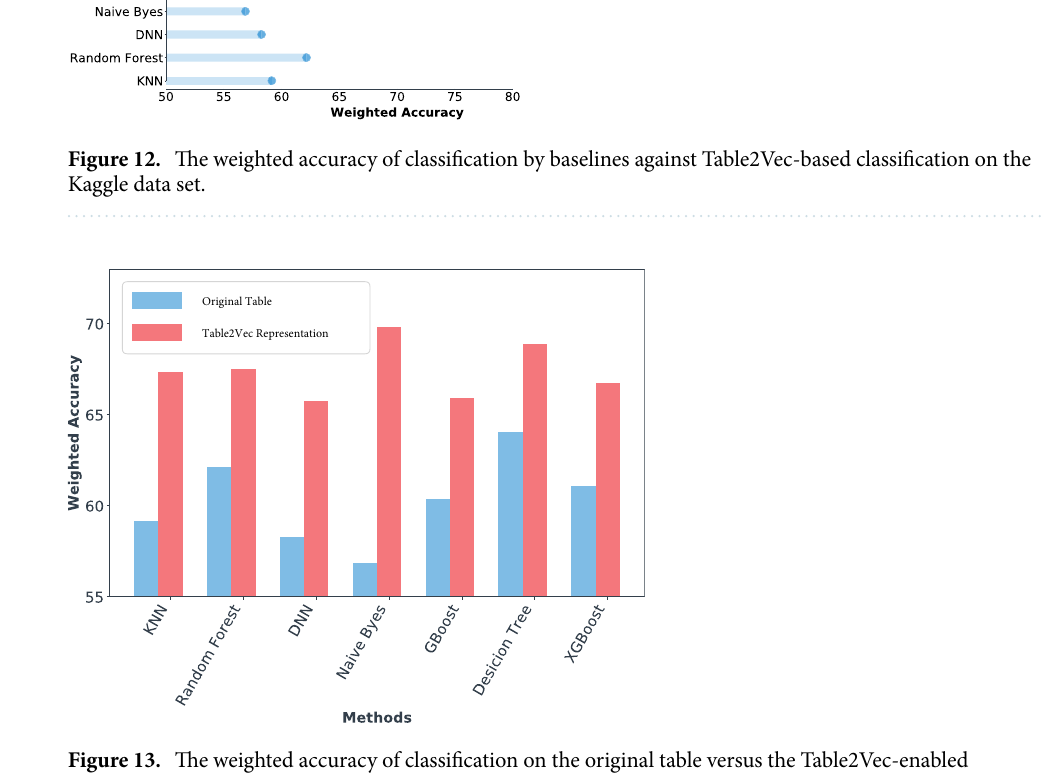
Figure 13. The weighted accuracy of classification on the original table versus the Table2Vec-enabled